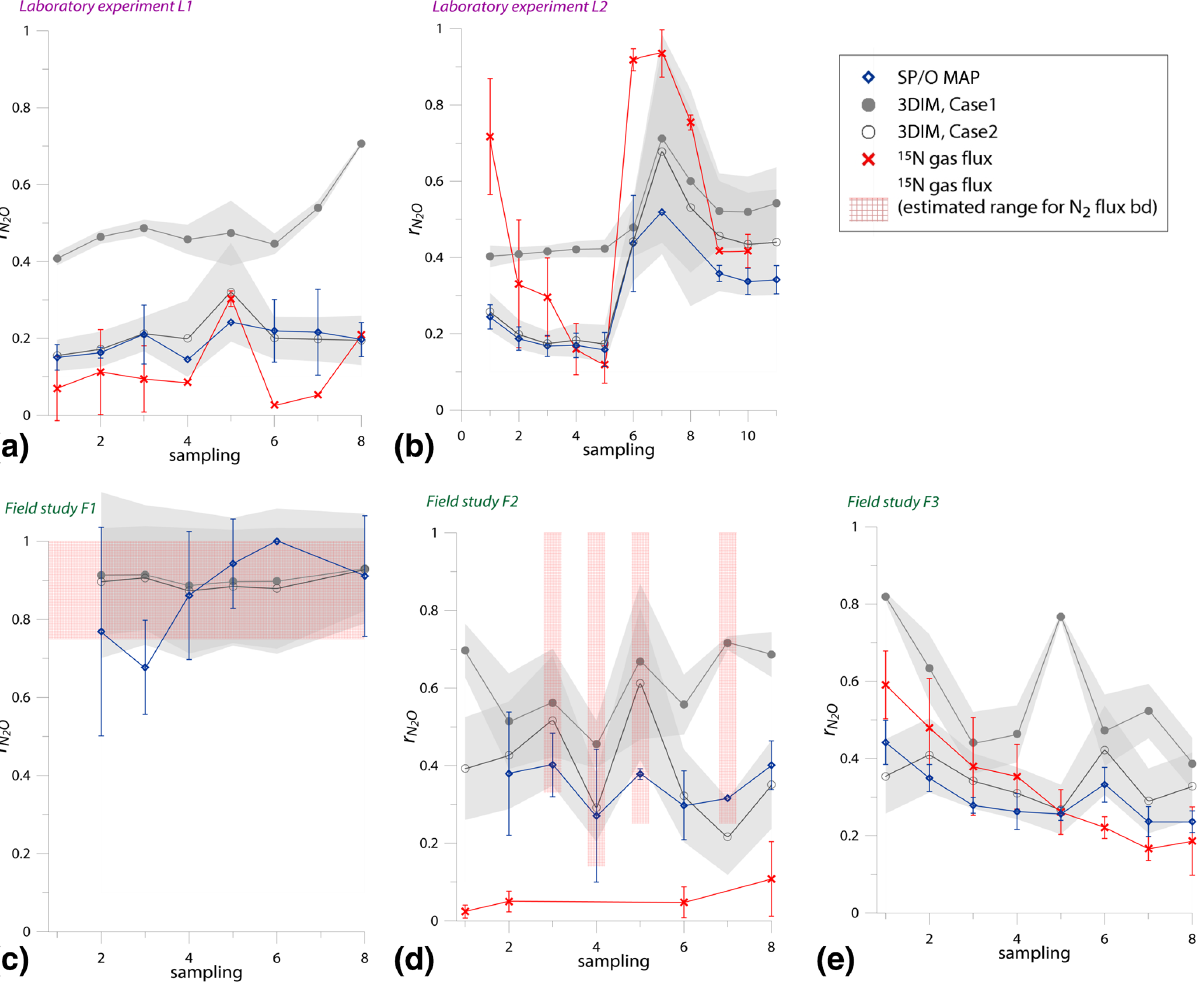
Figure 5. Comparison of time changes in residual N 2 O fraction ( r N method ( 15 N gas flux). For 3DIM results, the 95% confidence interval is shown with grey shaded areas. Error bars for O / SP MAP and 15 N gas-flux data represent the standard deviation of replicate samples ( n = 4). For N 2 fluxes below the detection limit, the estimated r N are shown (red areas), calculated with N 2 flux from 0 to 1 of the detection